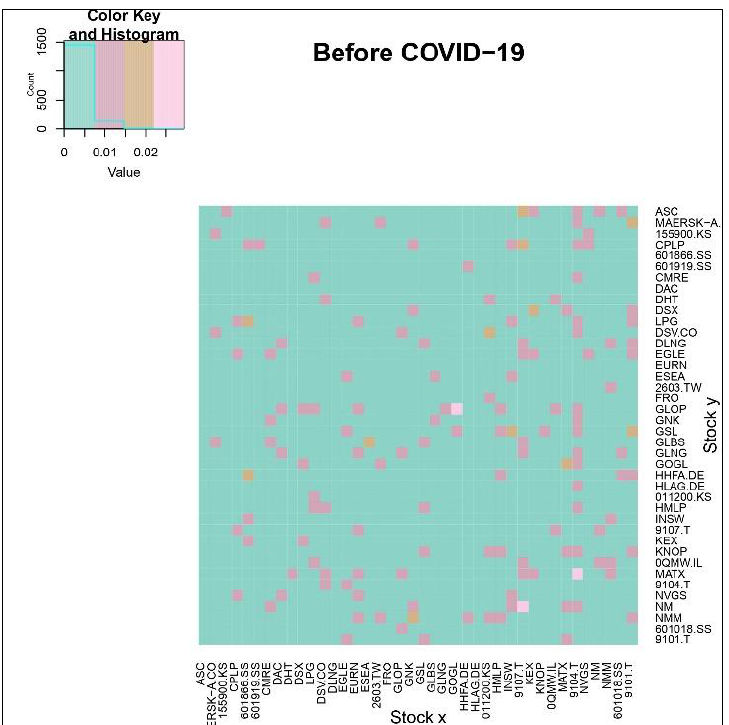
Figure 1. The information flow (effective transfer entropy) from stock y to stock x, for the companies 1 through 40 (listed